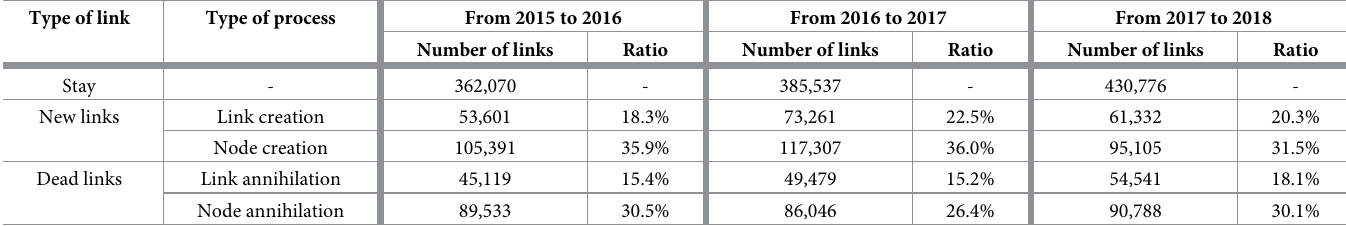
Table 4. Number of links on the citation networks by type from 2015 to 2018. Type of